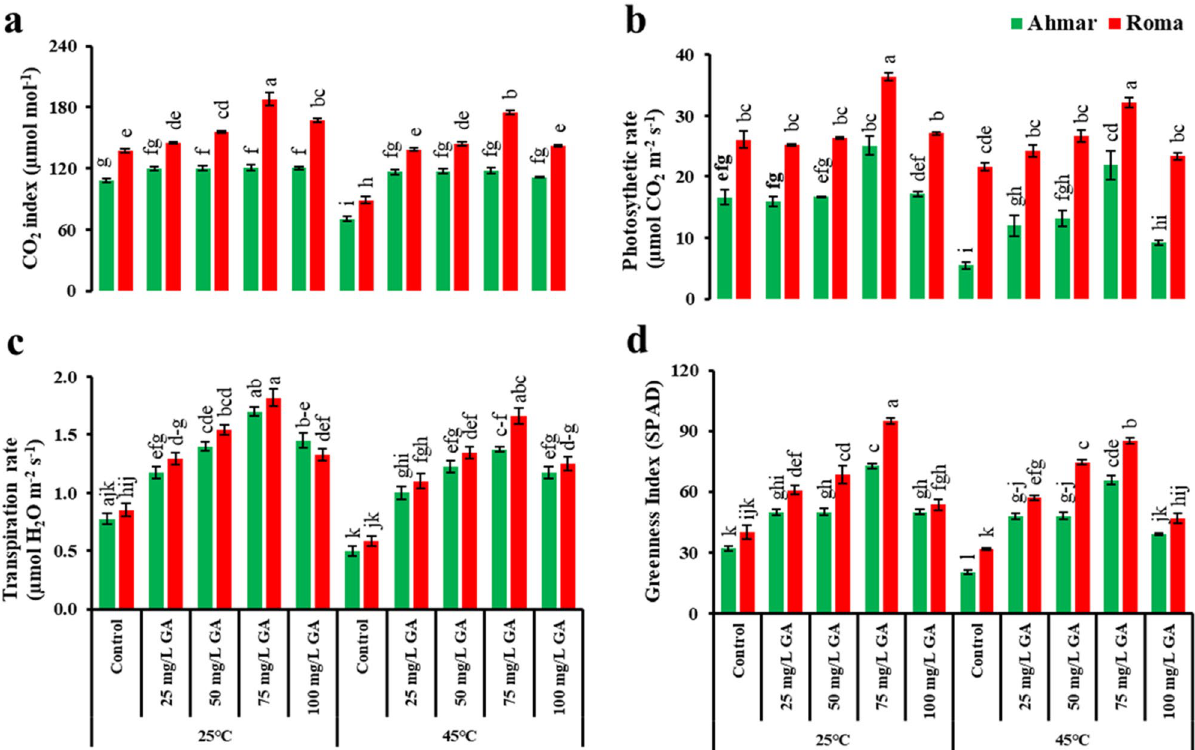
Figure 1. Physiological variables of tomato as affected by temperature, genotype and exogenous application of GA 3 . According to Tukey’s honestly significant difference test, the same letters suggest that there is no statistically significant difference between treatments ( p ≤ 0.05). Vertical bars indicate average ± standard error (n = 4, 5 plants per